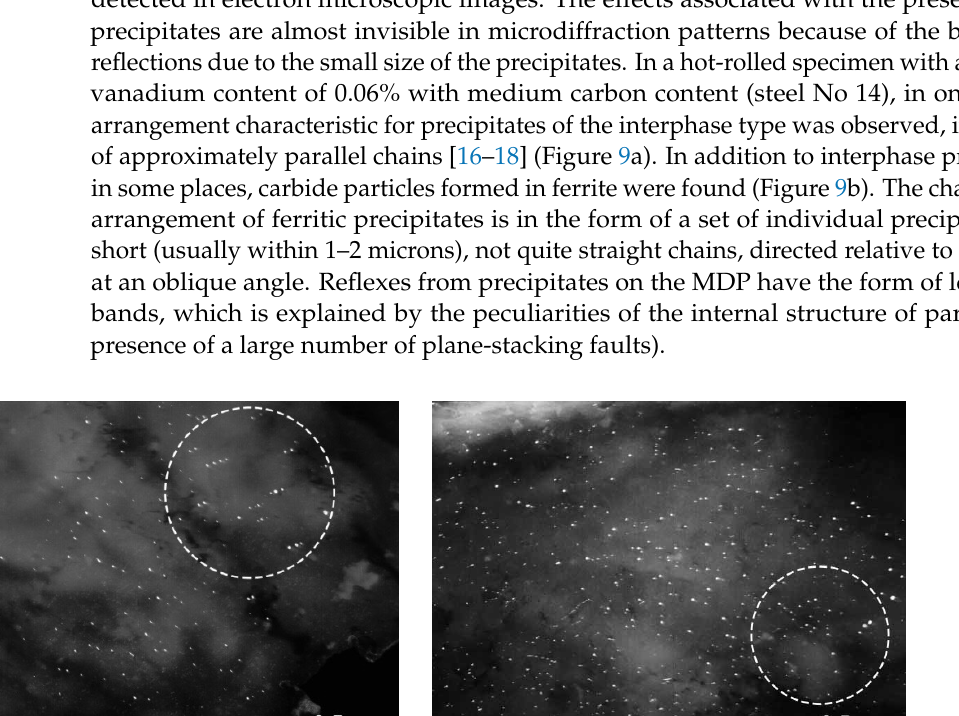
Figure 8. Brightfield image: view of submicron precipitates in steel No 5 (arrows indicate some precipitates): ( a ) Shape precipitates is dendritic; ( b ) Closer to equiaxial.